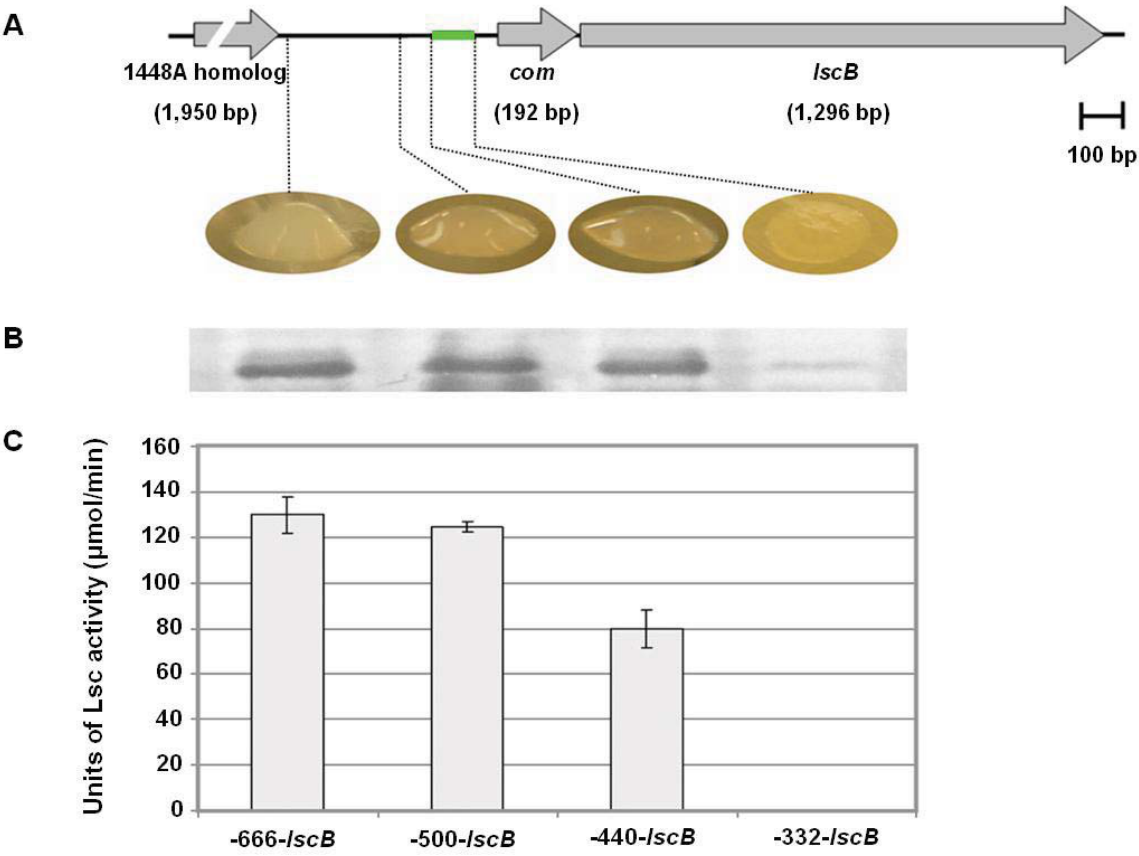
■ ) represents the promoter region of lscB